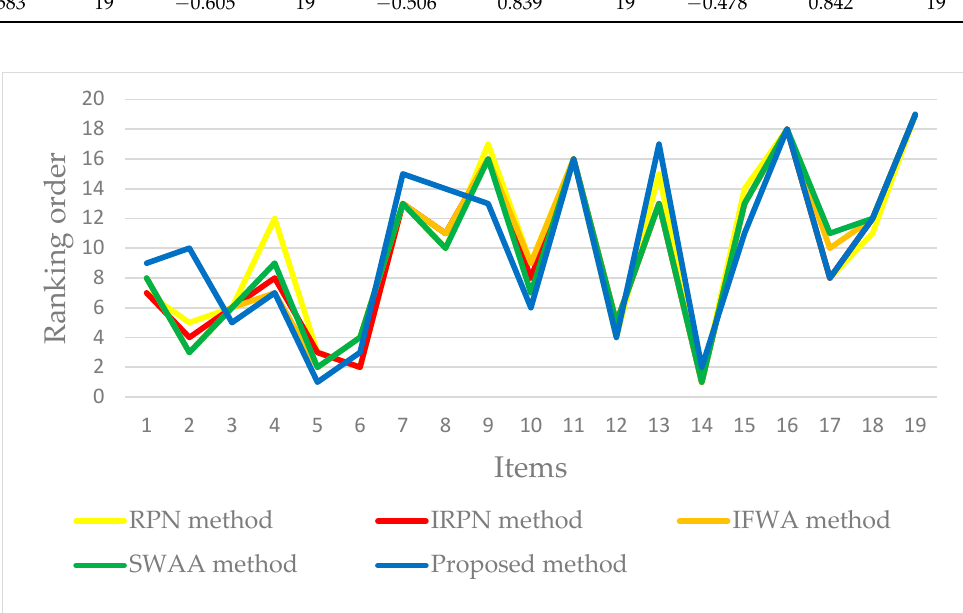
Figure 2. The risk-ranking results of di ff erent calculation methods.